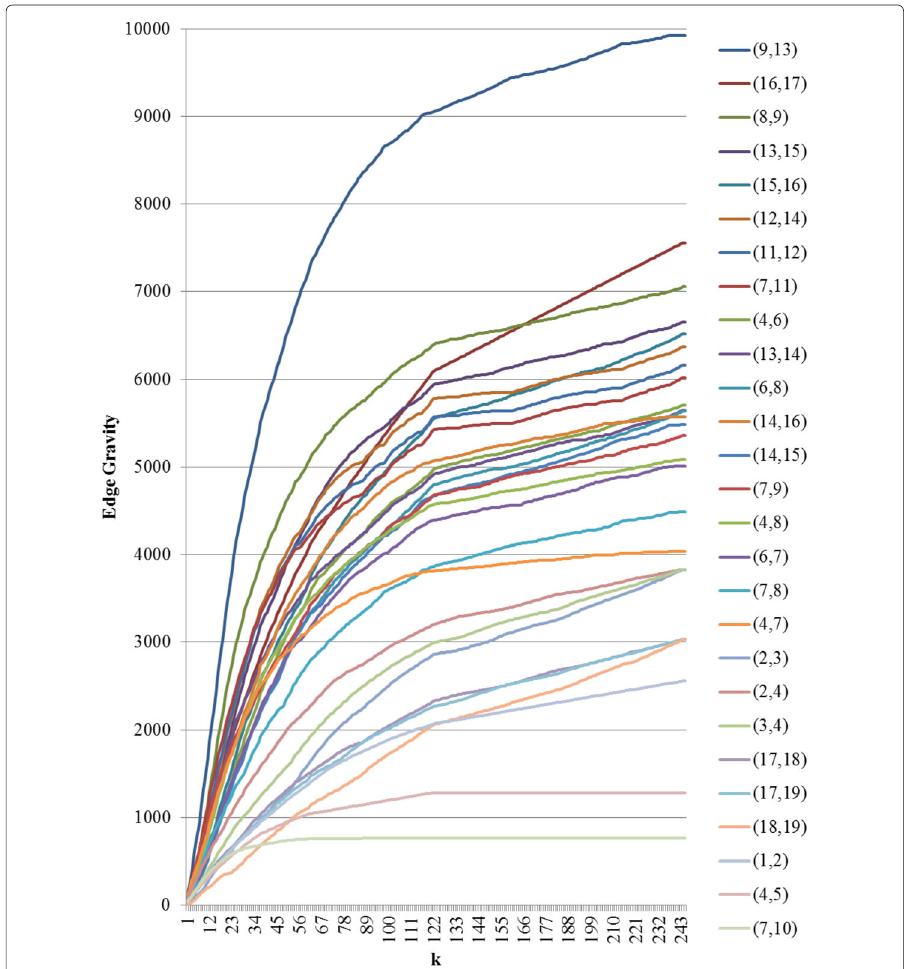
Fig. 20 Edge Gravity labels and ranking for the original Krebs network, when solving for k = 1,2,3, ...